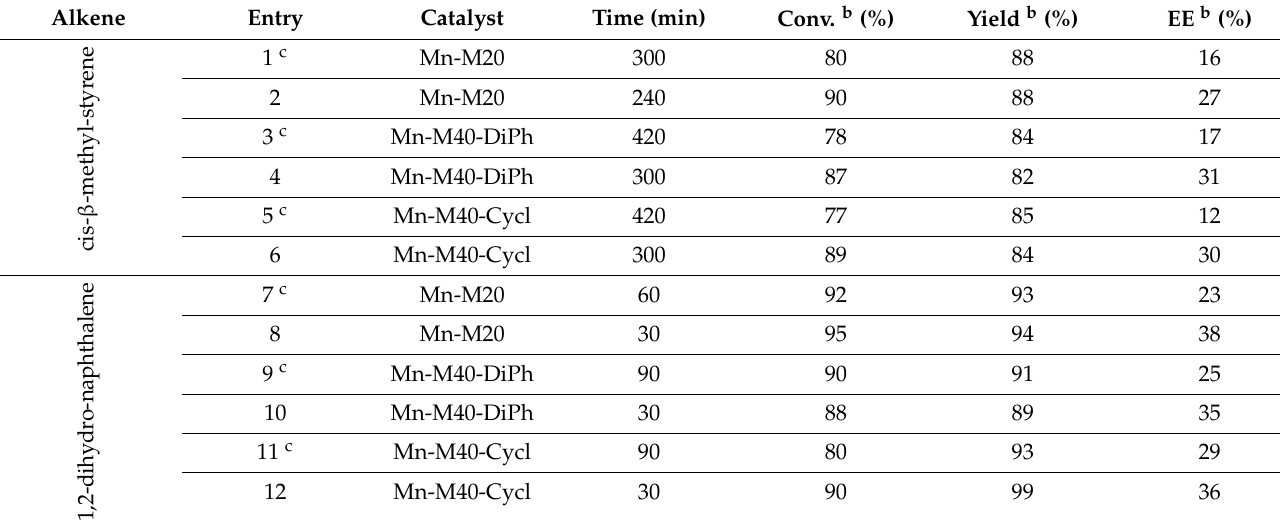
Table 1. Enantioselective epoxidation of alkenes with NaClO catalyzed by Mn macrocycle catalysts a .